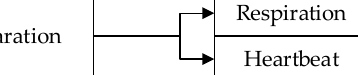
Figure 3. Traditional FIR filtering method.